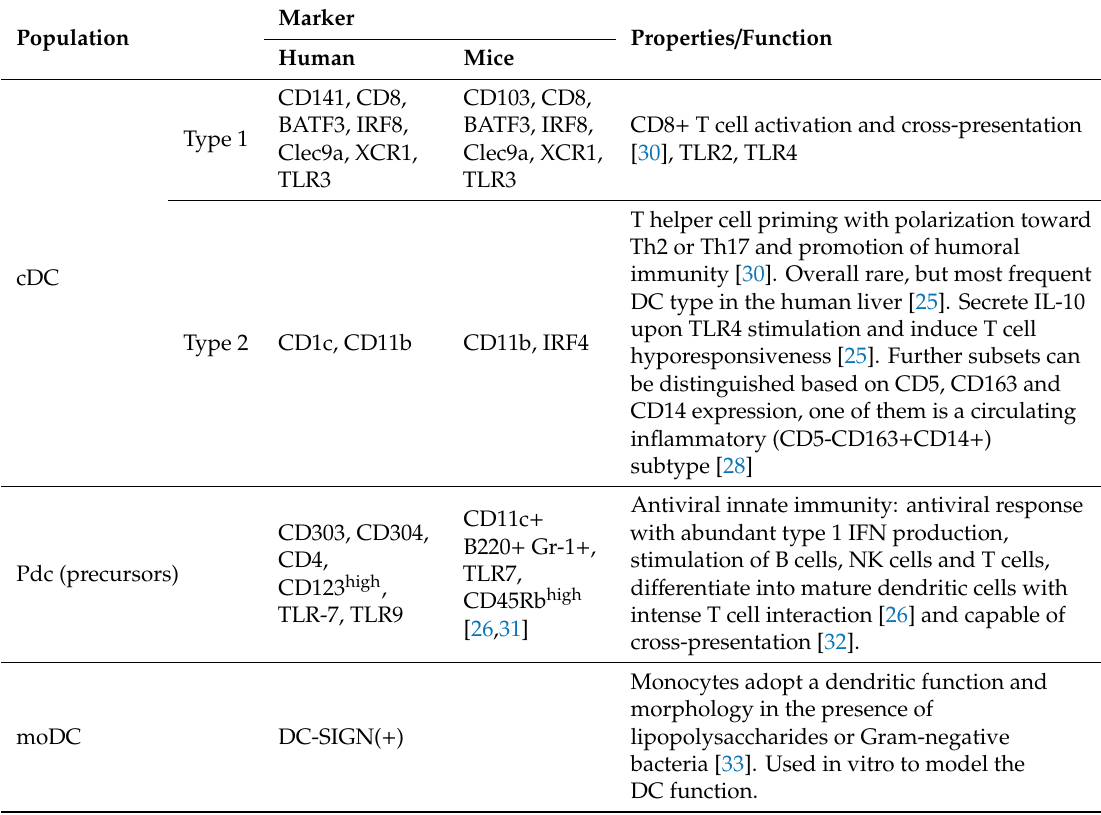
Table 1. Overview of dendritic cell populations with a focus on T cell